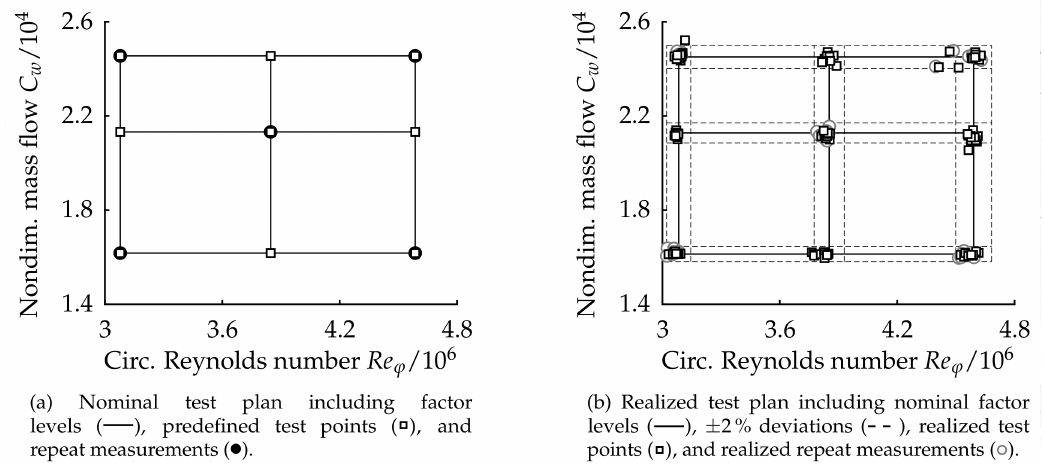
Figure 4. Comparison between nominal test plan and realized test plan for Reynolds number Re ϕ and mass flow C w